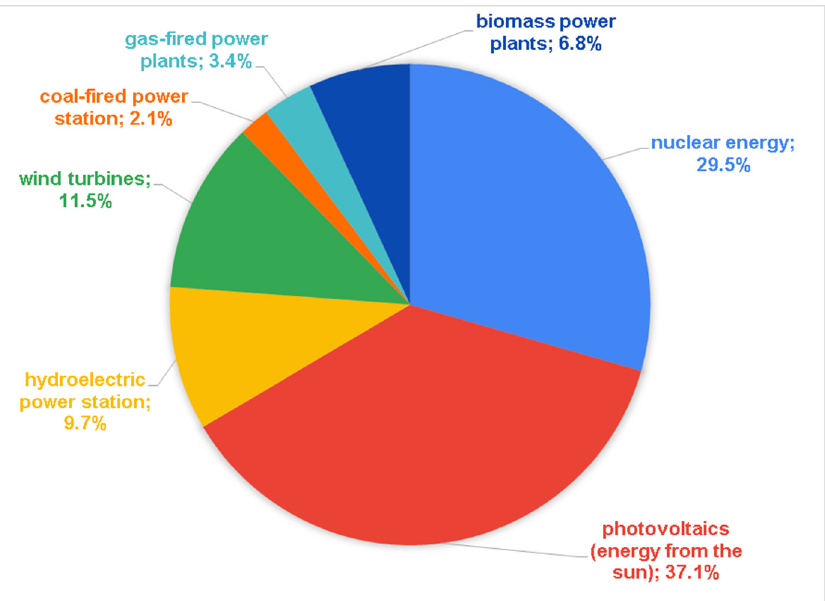
Figure 8. Respondents’ expectations regarding the direction of the development of the energy sector in Poland.